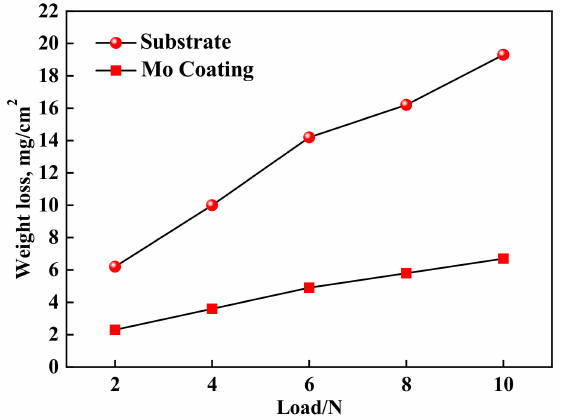
Figure 17. Curves of wear resistance for substrate and coating.